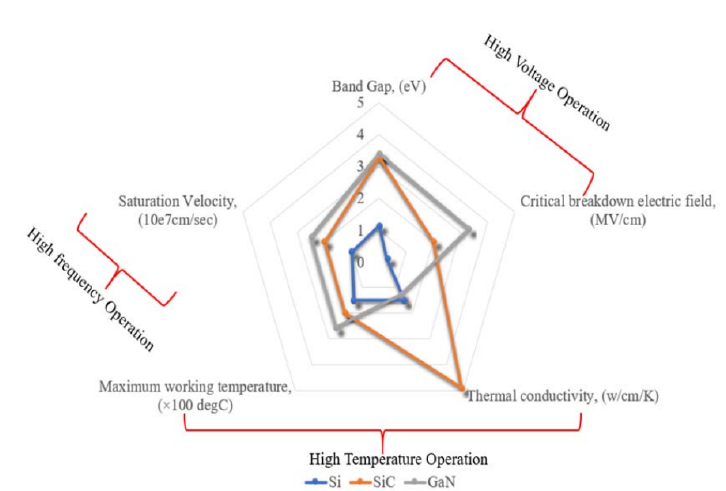
Figure 3. Material properties of Si-, SiC- and GaN-based semiconductors